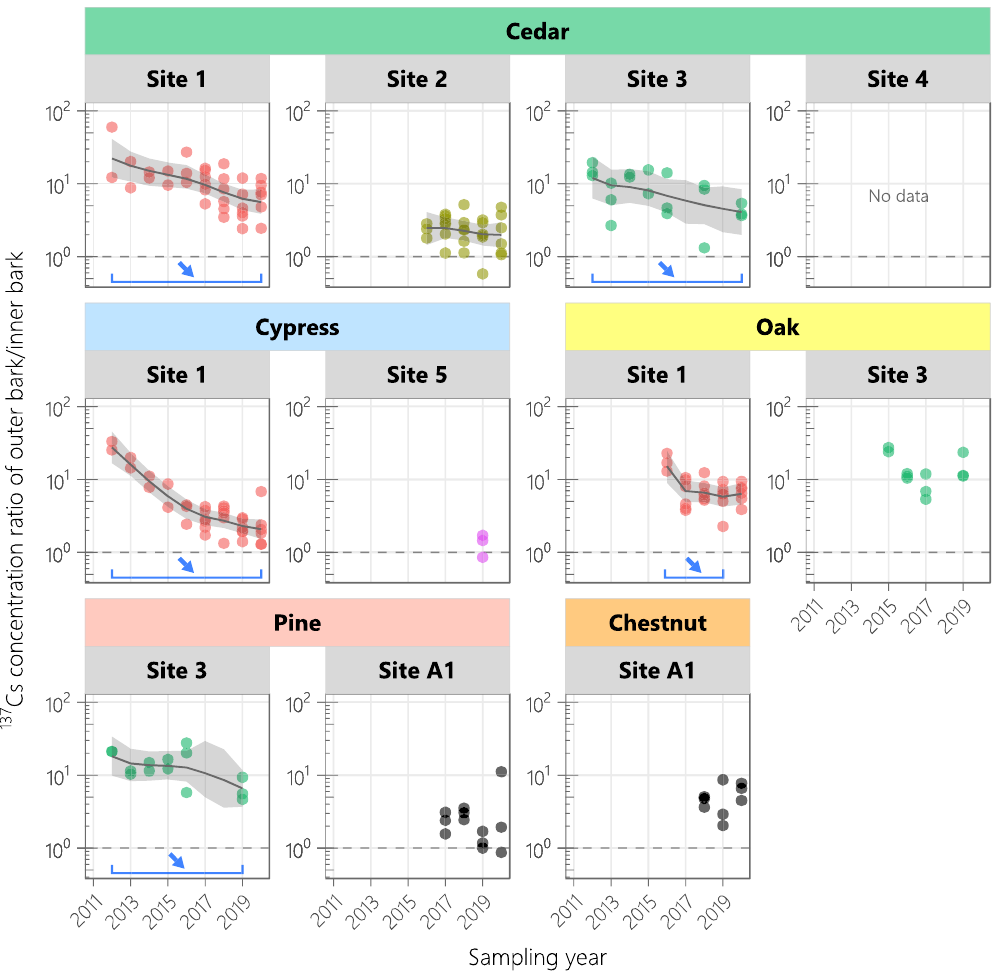
Figure 3. Temporal variations in 137 Cs concentration ratio of outer bark/inner bark. Circles show the observed values. The true states were estimated using a dynamic linear model, and the median values and 95% credible intervals are shown by solid lines and shaded regions , respectively. Horizontal lines indicate significant differences between the estimated true state values in the years at the both ends (delimiting